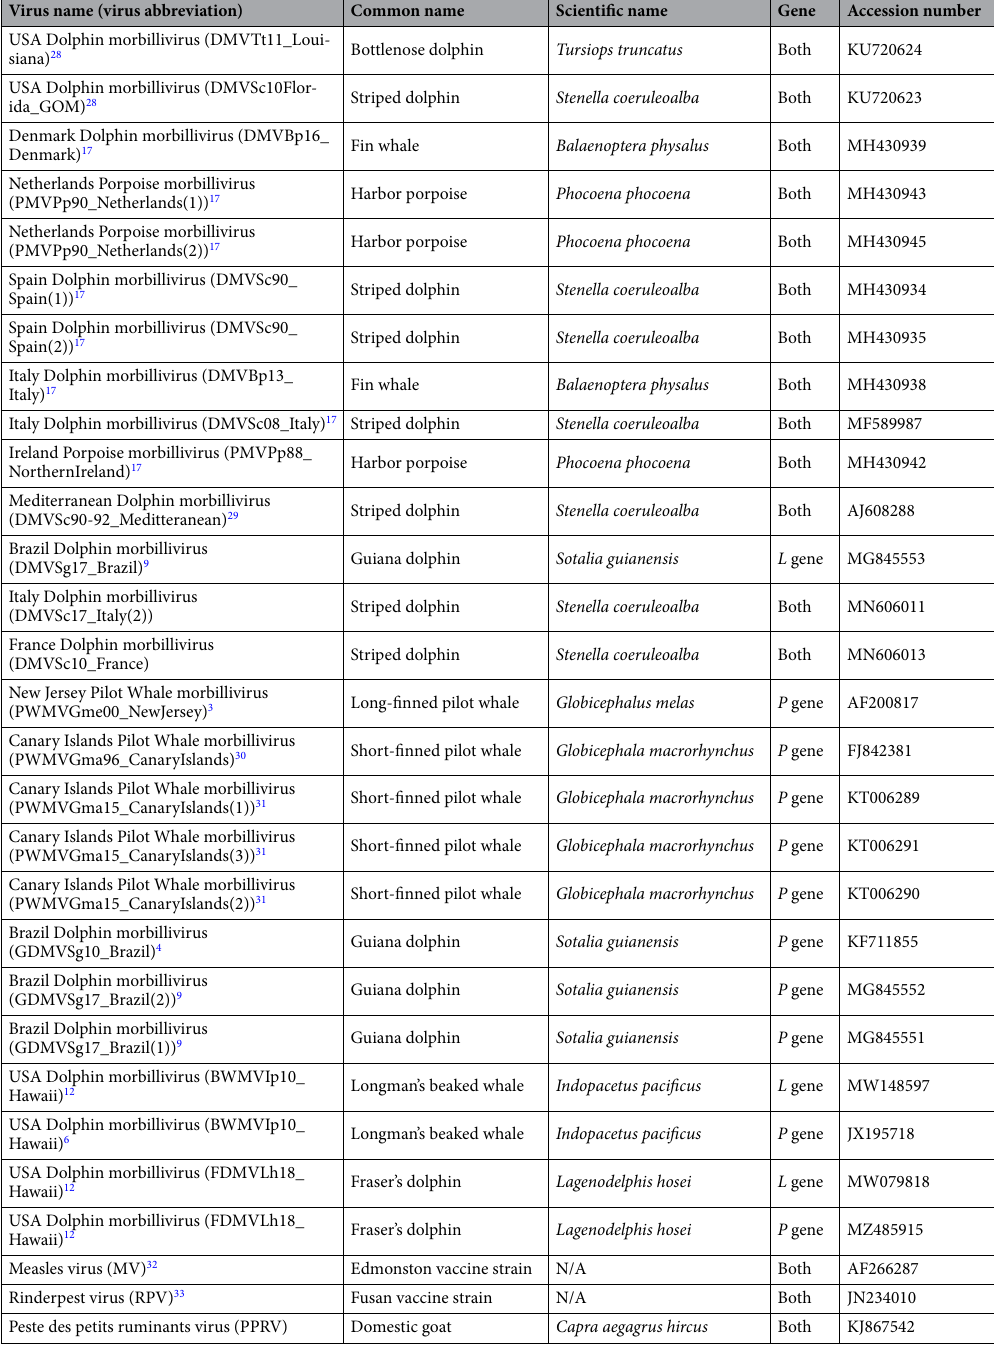
Table 2. Virus names, GenBank accession numbers, target gene and references for the morbilliviruses used in the genetic analysis of the L and P